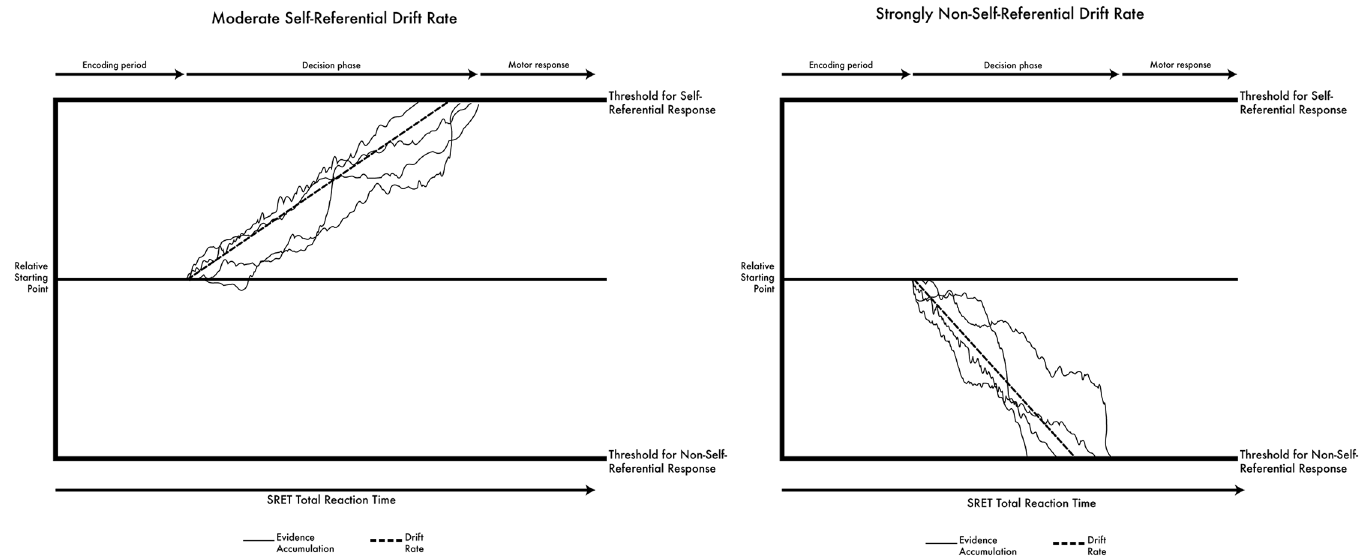
Fig 1. Illustration of the diffusion model. The two schematics shown here represent a subset of trials selected from hypothetical results for two conditions. The left image displays a moderate, self-referential drift rate (i.e. positive slope, low absolute value), and the right image displays a strong, non-self-referential drift rate (i.e. negative slope, high absolute value). Overall SRET reaction time is broken down into three components: encoding period, decision phase, and motor response. During the decision phase, evidence accumulation begins at the relative starting point (which varies across subjects) and continues until one of the thresholds is met. The time taken to reach the threshold across all trials is used to determine drift rate. Two drift rates were generated for each individual, one pertaining to decision making for positive adjectives and one for negative adjectives.